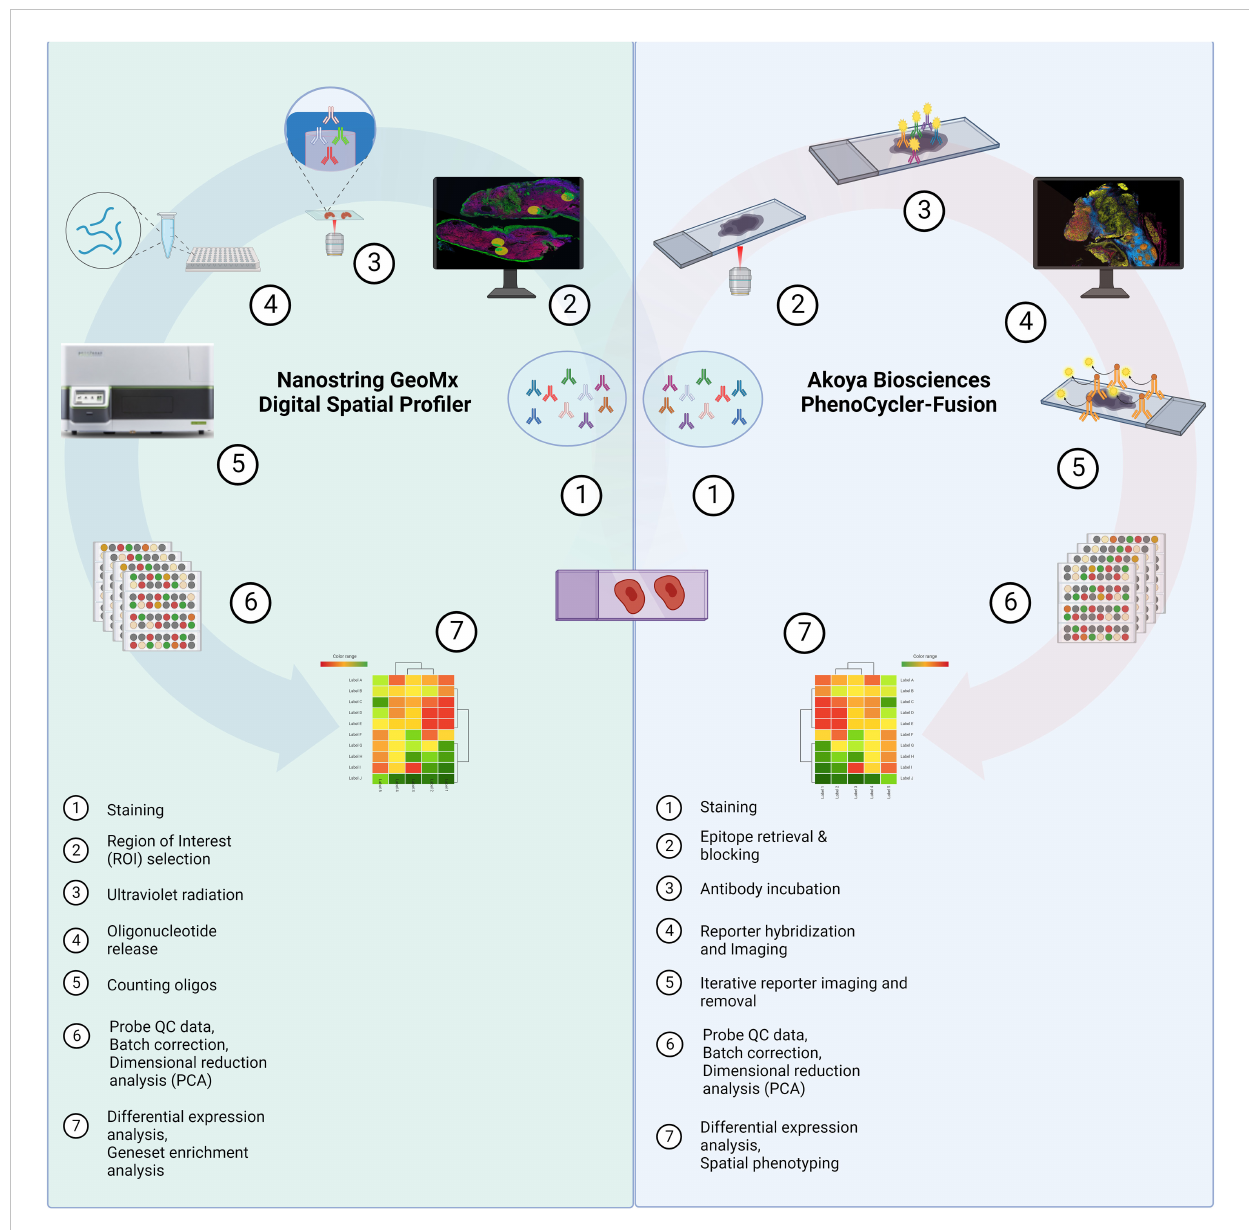
FIGURE 1 Study Schema. Formalin- fi xed paraf fi n-embedded (FFPE) tissue samples were collected from HNSCC patients prior to immunotherapy from the Royal Brisbane and Women ’ s Hospital (RBWH). Targeted spatial proteomics across the cohort was performed with the Nanostring GeoMx Digital Spatial Pro fi ler (DSP) and a sub-cohort analysis using the Akoya PhenoCycler-Fusion platform. Data analysis consisted of probe quality control (QC), principal component analysis (PCA), differential expression, and Cox proportional hazards (COXPH) and Kaplan-Meier models for survival analysis. Created by